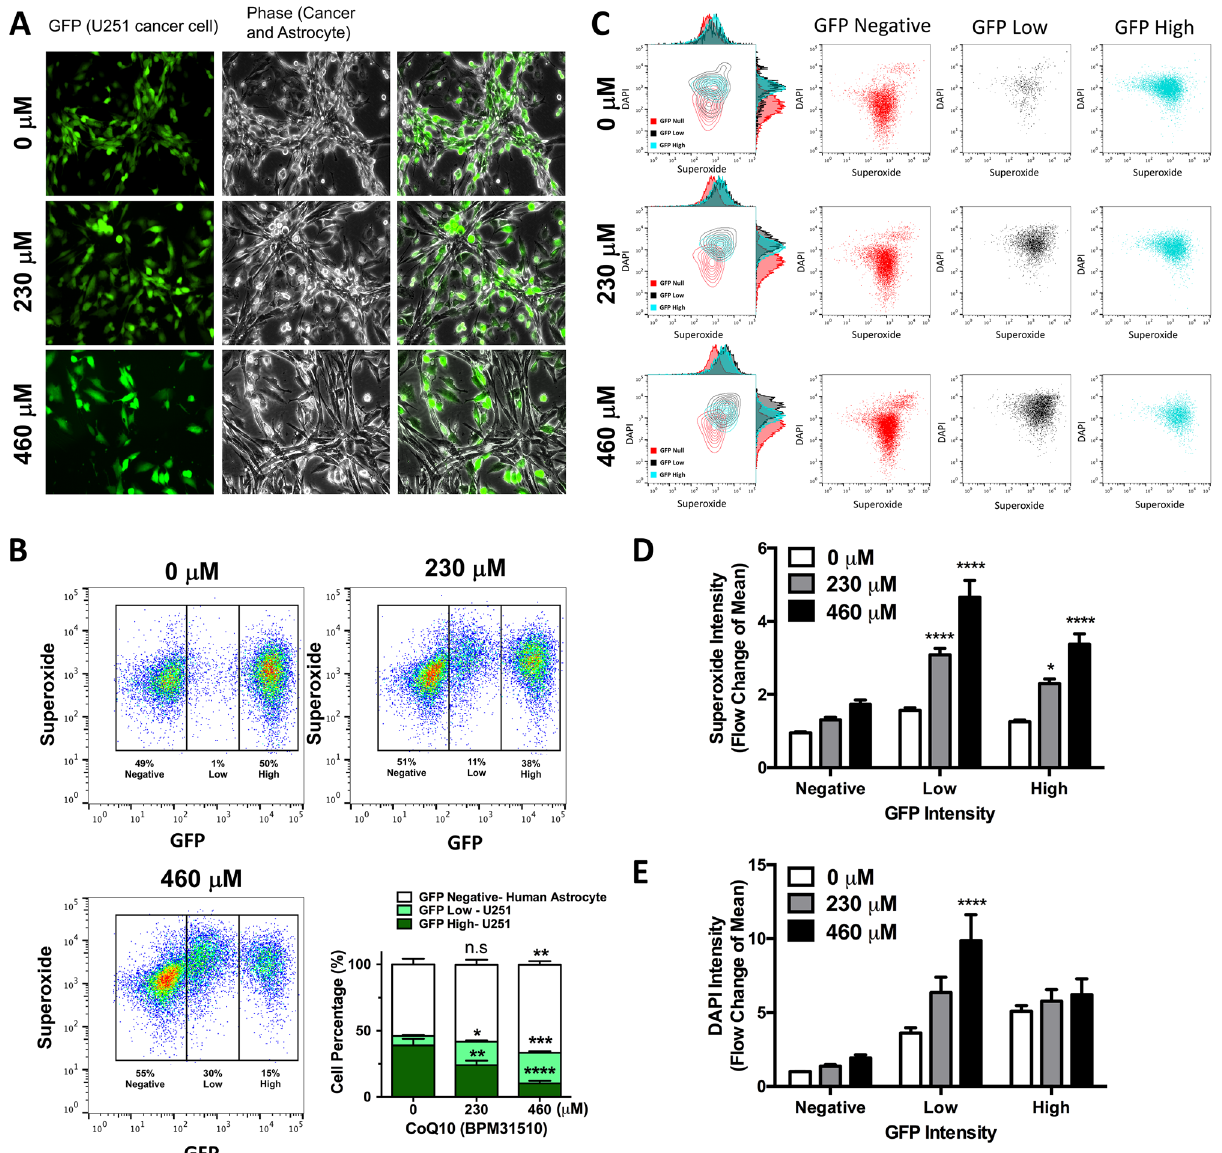
Figure 5. Ubidecarenone induces differential effects on cell growth and redox vulnerabilities between non-tumor and glioblastoma cells in co-culture experiments. ( A ) Phase and fluorescent images of GFP- labeled human U251 glioma cells and non-labeled HA cells co-cultured and treated with 0, 230, or 460 µM ubidecarenone demonstrate a dose-dependent decrease in glioma cells with a relative sparing of HA. (B ) Flow cytometry analysis (scatter plot) of GFP and O 2- in GFP-labeled human U251 glioma cells and non-labeled HA cells in co-culture. Cell populations are characterized based on GFP intensity (GFP neg , GFP low , and GFP high ). Note the dose-dependent increase in the GFP neg population relative to the GFP high population in the presence of ubidecarenone. Quantification of flow cytometry cell populations illustrates a dose-dependent increase in GFP low cell numbers. ( C ) Flow cytometry analysis of O 2− and DAPI in GFP-labeled human U251 glioma cells and non-labeled HA cells, co-cultured and treated with 0, 230, or 460 µM ubidecarenone. Note the increase in O 2− values for both GFP low and GFP high cells, with insignificant changes noted in the GFP neg (HA cells) population. ( D ) Graphical depiction of flow cytometry analysis of O 2− and DAPI in GFP-labeled human U251 glioma cells and non-labeled HA cells, co-cultured and treated with 0, 230, or 460 µM ubidecarenone. In contrast to the GFP neg population, BPM exposure results in a marked increase in superoxide production in both the low and high GFP fractions. ( E ) DAPI levels are significantly elevated only in the GFP low cell population, consistent with this population representing dying